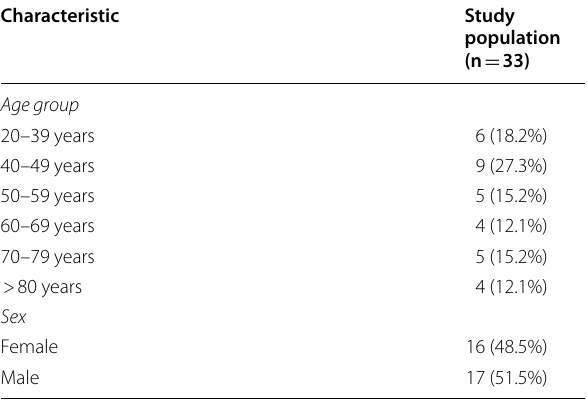
no evidence of venous disease, C1 = Active venous =